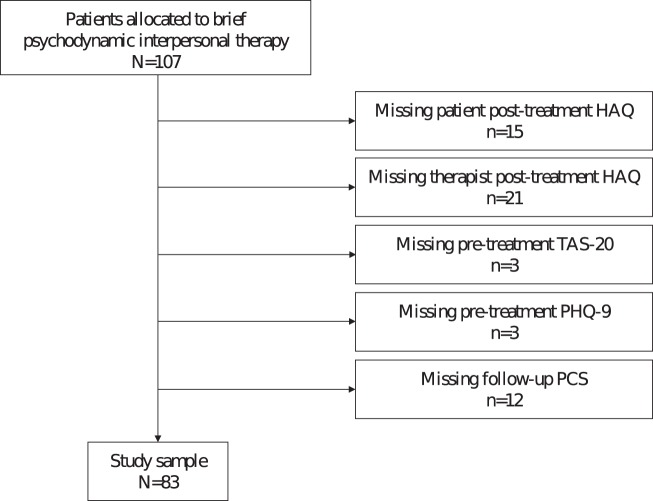
Flow-chart. Note: More missing questionnaires than excluded patients because of multiple missing questionnaires per excluded patient. Abbreviations: HAQ, Helping Alliance Questionnaire; TAS-20, Toronto Alexithymia Scale; PHQ-9, Depression scale of the Patient Health Questionnaire; PCS, Physical Component Summary of the SF-36 Health Survey.